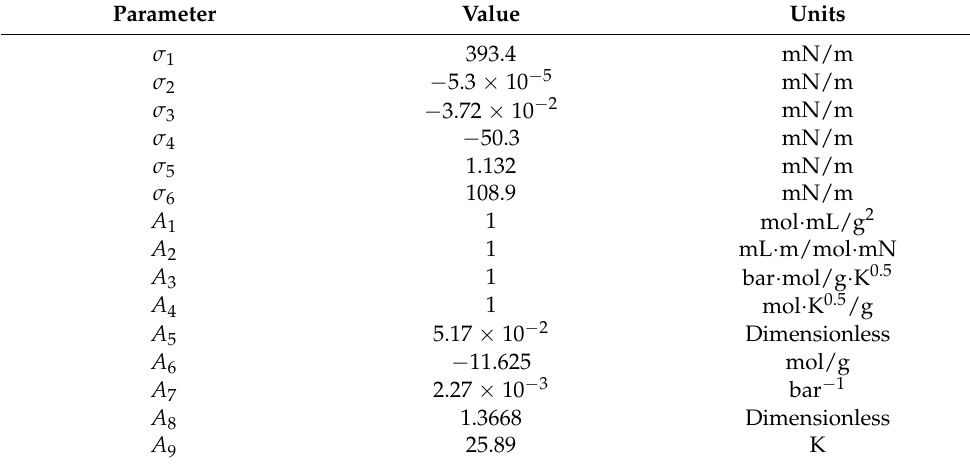
Table 7. Adjusted and optimized parameters for the proposed models of Equations (2) and (3). Parameter